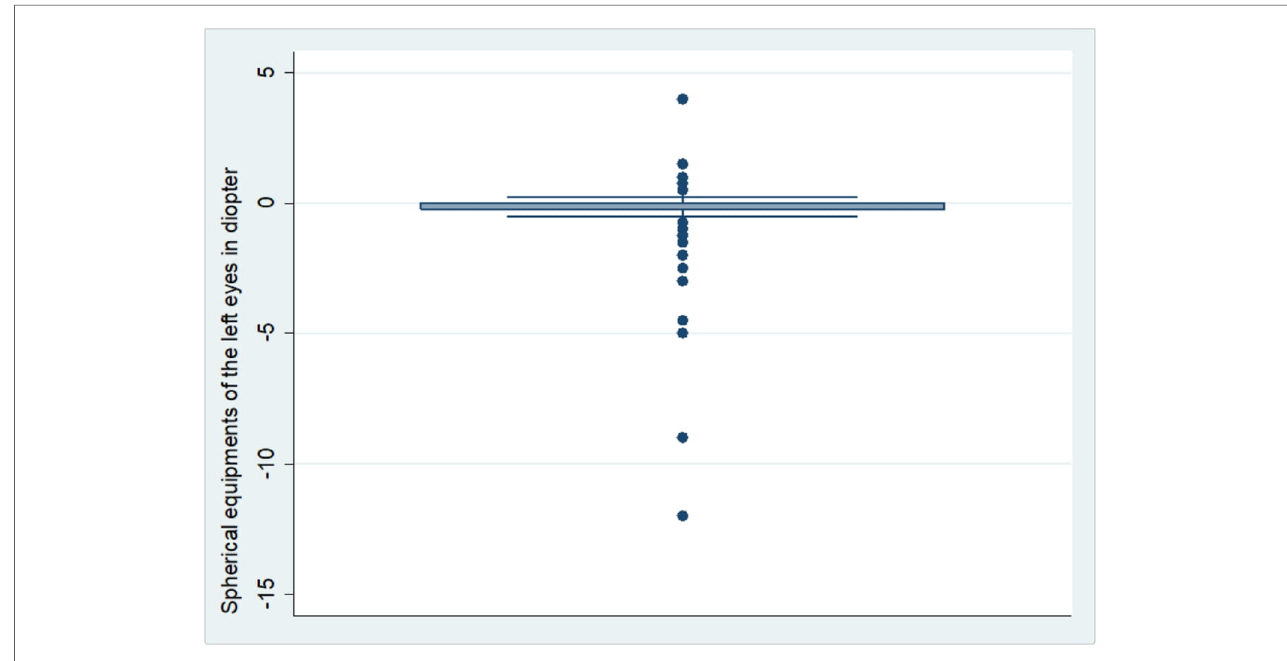
FIGURE 2 Distribution of spherical equivalent on the left eyes of pregnant women ( n =423).